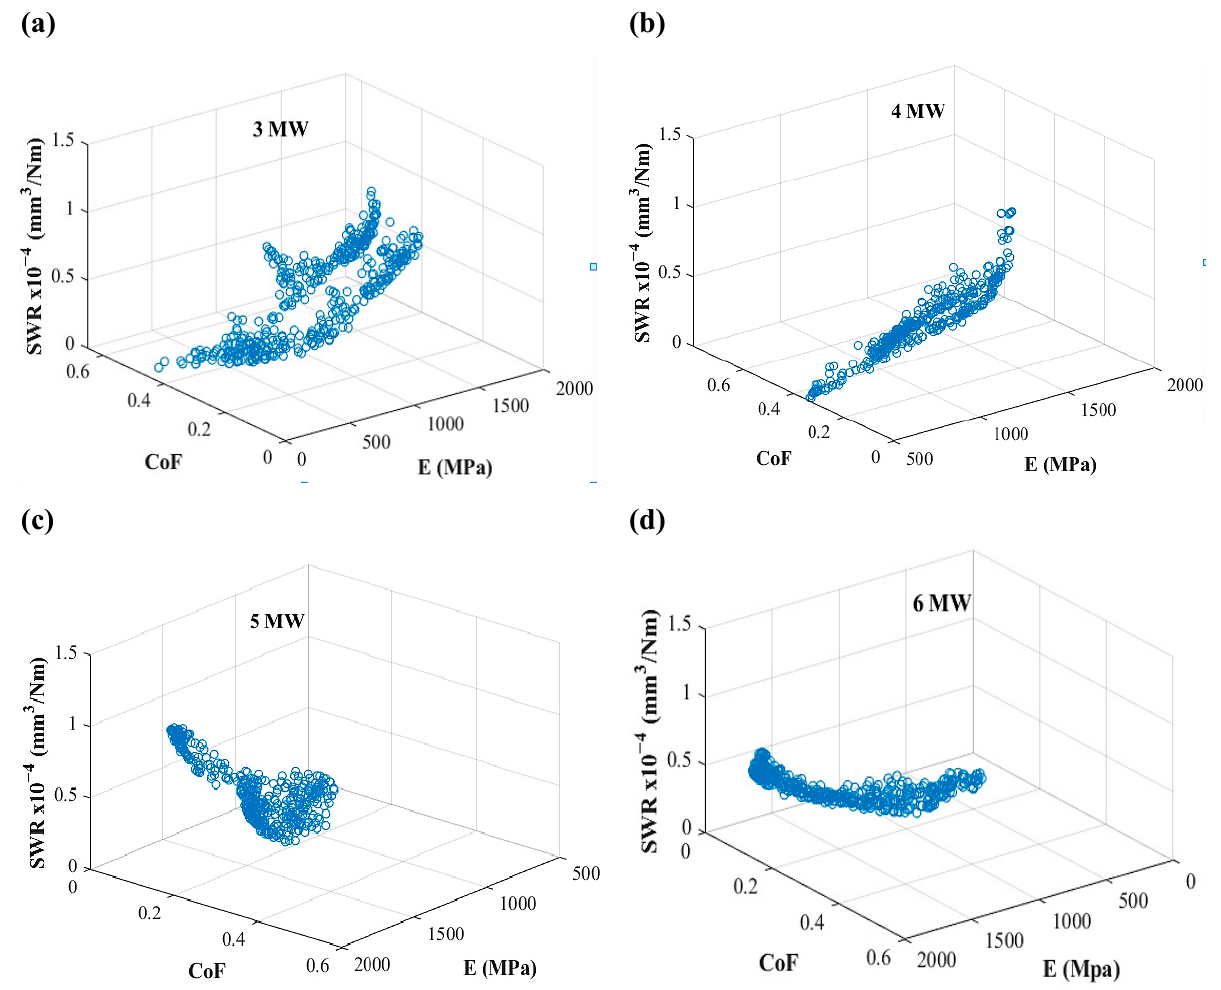
Figure 7. 3D Pareto front of E, CoF, and SWR without constraints on varying the molecular weight of UHMWPE ( a ) 3, ( b ) 4, ( c ) 5, and ( d ) 6.